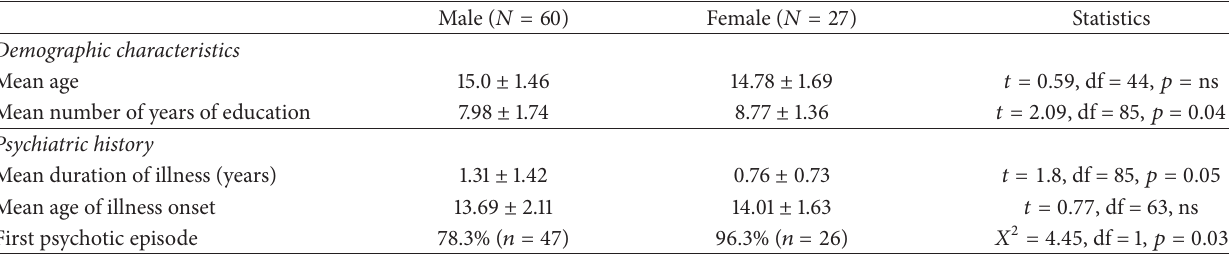
Table 1: Demographic and clinical characteristics of male and female patients.